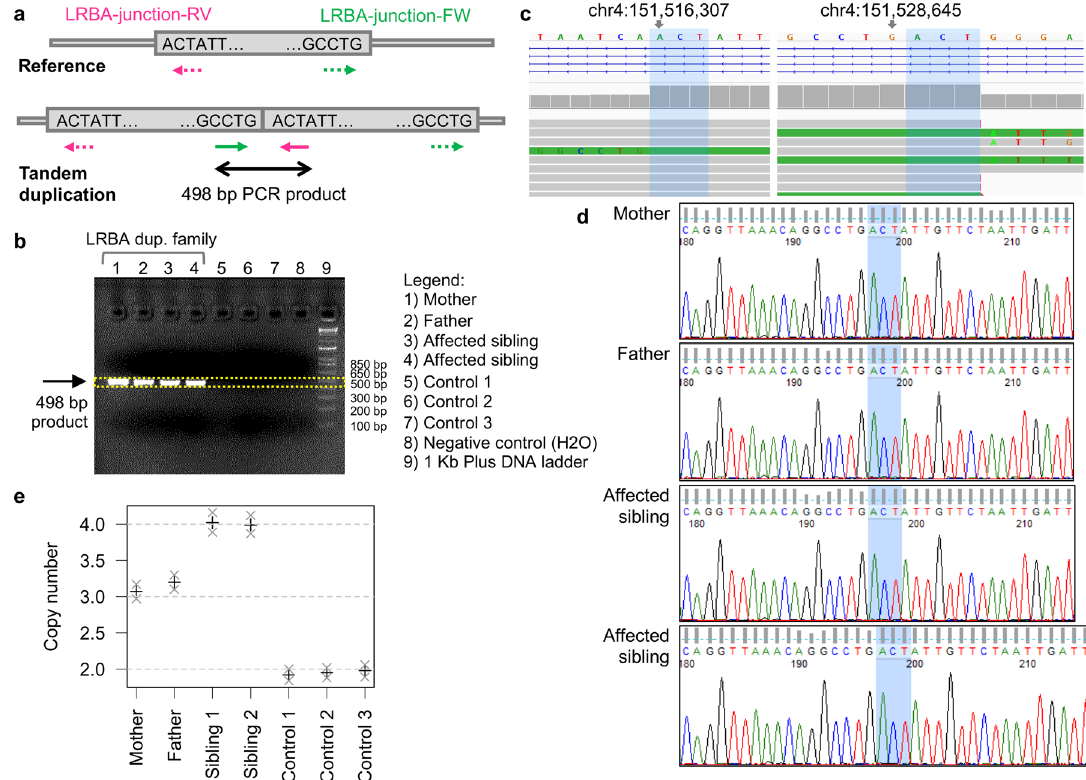
Fig. 2 Validation and segregation experiments. a PCR primer design and breakpoint sequence (note that the sequence is not in scale relative to primer position). b PCR results, with the product corresponding to the tandem duplication junction present only in the four family members but not in controls. c Duplication breakpoints from WGS read alignment (visualized in IGV), note that this incorrectly suggests that the ACT microhomology sequence (blue shade) is present both at the beginning and the end of the duplication; also note that aligned reads displaying multiple substitutions (colored nucleotides within the read bars) correspond to junction-spanning reads and in fact present exactly the same sequence as identi fi ed by Sanger sequencing the junction PCR product. d Sanger sequencing of the PCR product showing the expected sequence. e ddPCR showing copy number 3 in the parents, copy number 4 in the affected siblings and copy number 2 in controls ( + indicates the point estimate, x indicates the 95% Poisson con fi dence